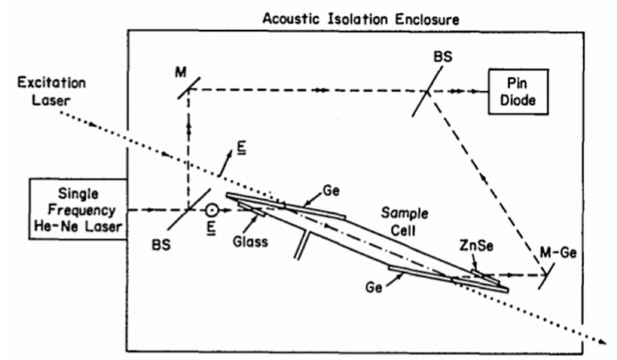
Figure 2. Schematic of the Mach-Zehnder interferometer-type photothermal gas sensor. BS—beam splitter, Ge—germanium window, M—mirror, ZnSe—zinc selenide window, E—beam polarization vector direction, M-Ge—germanium mirror. Reprinted with permission from [18] C The Optical Society.